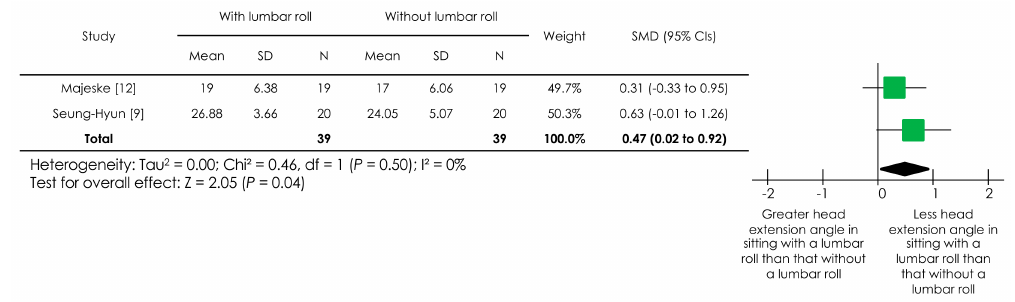
Figure 4. Forest plot of the effect of a lumbar roll in sitting on a head angle. Abbreviations: SMD, standardized mean difference; CIs, confidence